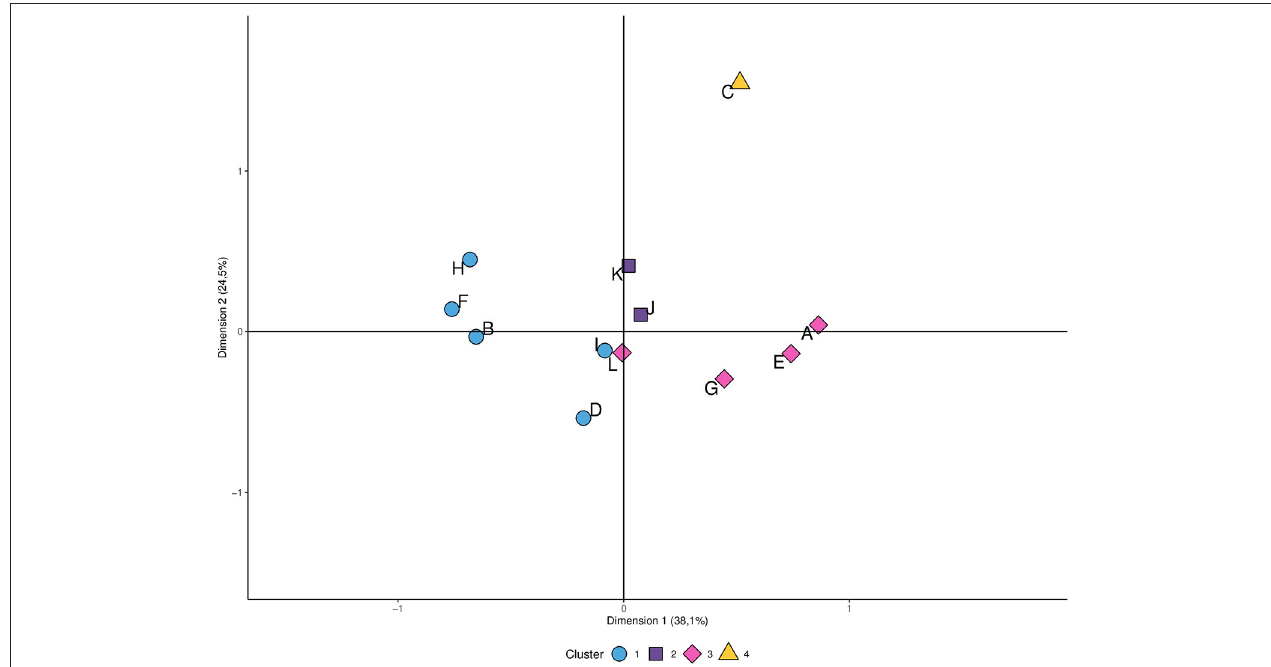
FIGURE 2 | Clustering of variables associated with the potential exposure of domestic animal to avian influenza viruses. Symbols with the same shape or color belong to the same cluster and their particular characteristics appear below in correspondence with the letter that identifies them. Cluster 1: Hunt with dog (B); Clean birds at home (D), Having backyard poultry at home (F), Feed domestic animal with bird leftover (H), High hunter experience (I); Cluster 2: Low hunter experience (J), Haven’t knowledge on avian influenza (K); Cluster 3: Don’t hunt with dog (A), Haven’t backyard poultry at home (E), Don’t feed domestic animal with bird leftover (G); Have knowledge on avian influenza (L); Cluster 4: Don’t clean birds at home